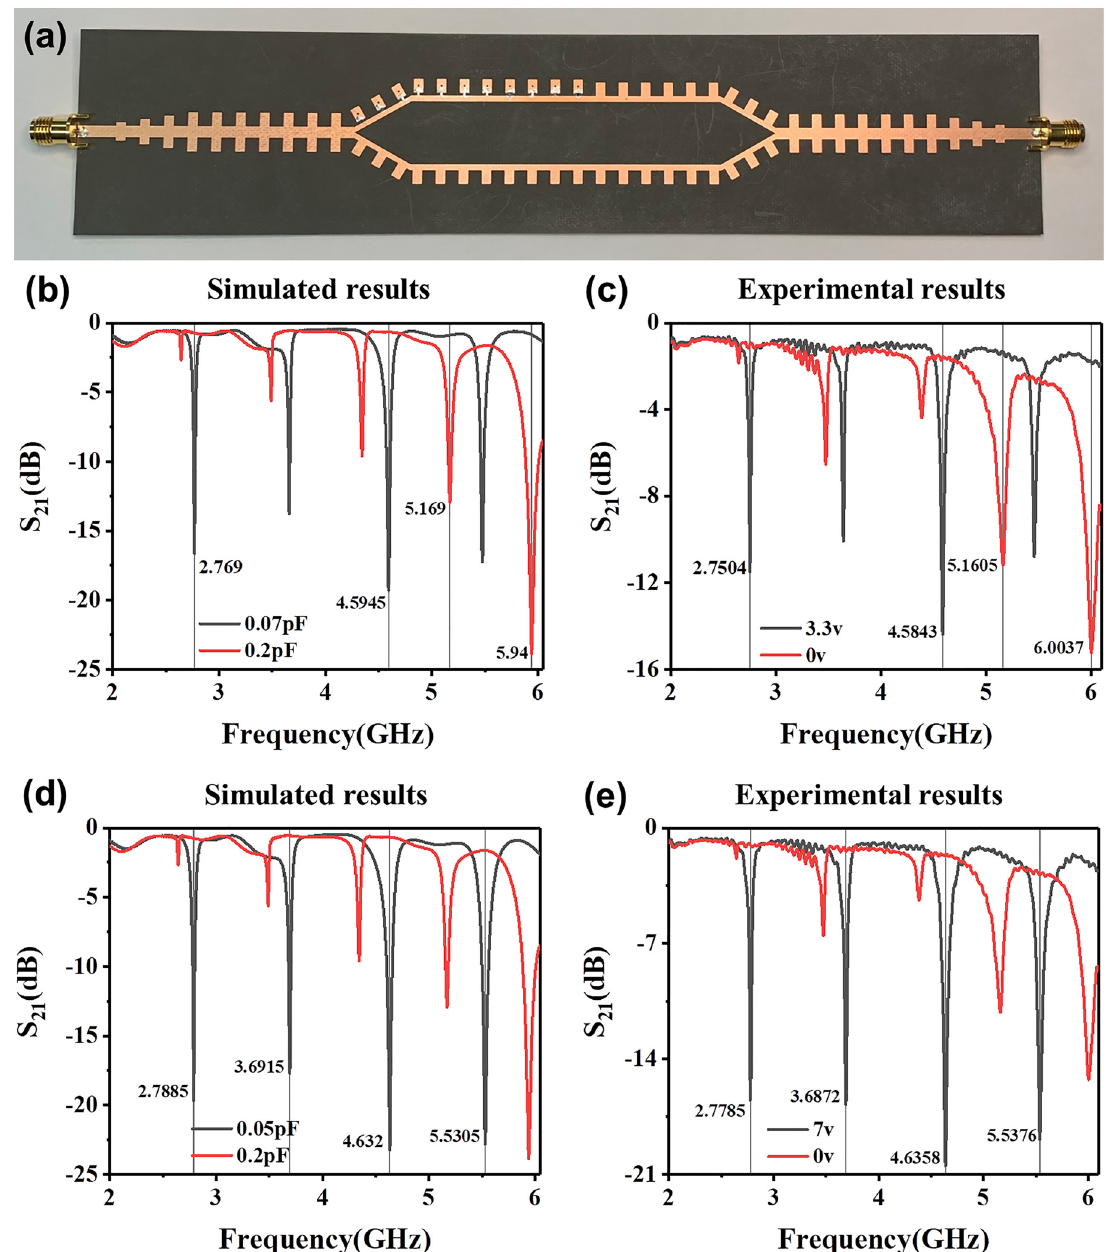
Figure 4: The fabricated reconfigurable SSPP-based MZI and measured results. (a) Photo of the recon fi gurable SSPP-based MZI structure showninFigure2(b).(b)ThesimulatedS 21 curveswithcapacitance0.07pFand0.2pFand(c)theircorrespondingexperimentalresults.(d)The simulated S 21 curves with capacitance 0.05 pF and 0.2 pF and (e) their corresponding experimental